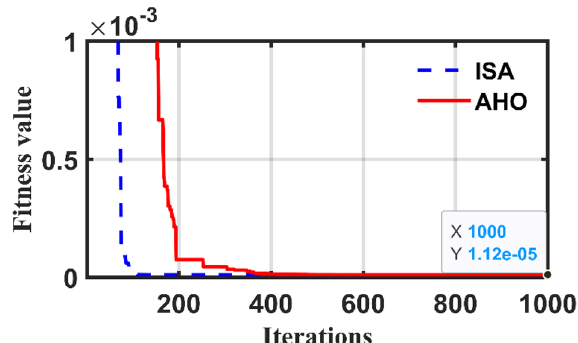
Figure 6. Convergence of the applied optimizers for case 2.